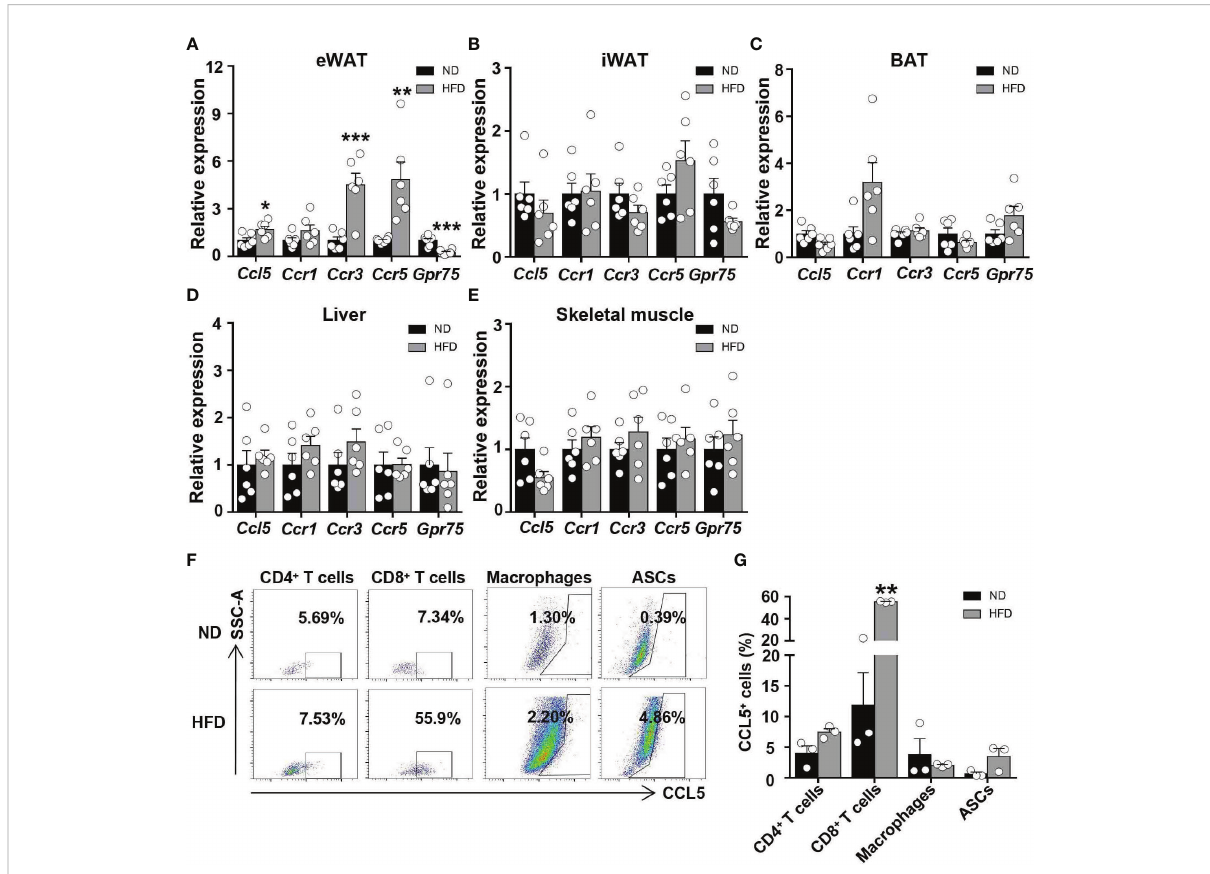
FIGURE 1 CCL5 is upregulated in CD8 + T cell in eWAT of obese mice. (A-E) mRNA expression of CCL5 and its receptors in eWAT (A) , iWAT (B) , BAT (C) , liver (D) and skeletal muscle (E) in ND-fed and 16-week HFD-fed mice. (n = 6 mice per group). (F) Representative fl ow cytometry plots of CCL5 expression in CD4 + T cells, CD8 + T cells, macrophages, and ASCs of ND-fed and 16-week HFD-fed mice. (G) Quanti fi cation of CCL5 + cells in CD4 + T cells, CD8 + T cells, Macrophages, and ASCs in C57BL/6J mice fed the ND or HFD by fl ow cytometry analysis. (n = 3 mice per group). Data are mean ± s.e.m. * p <0.05, ** p <0.01, *** p <0.001 by unpaired Student ’ s t